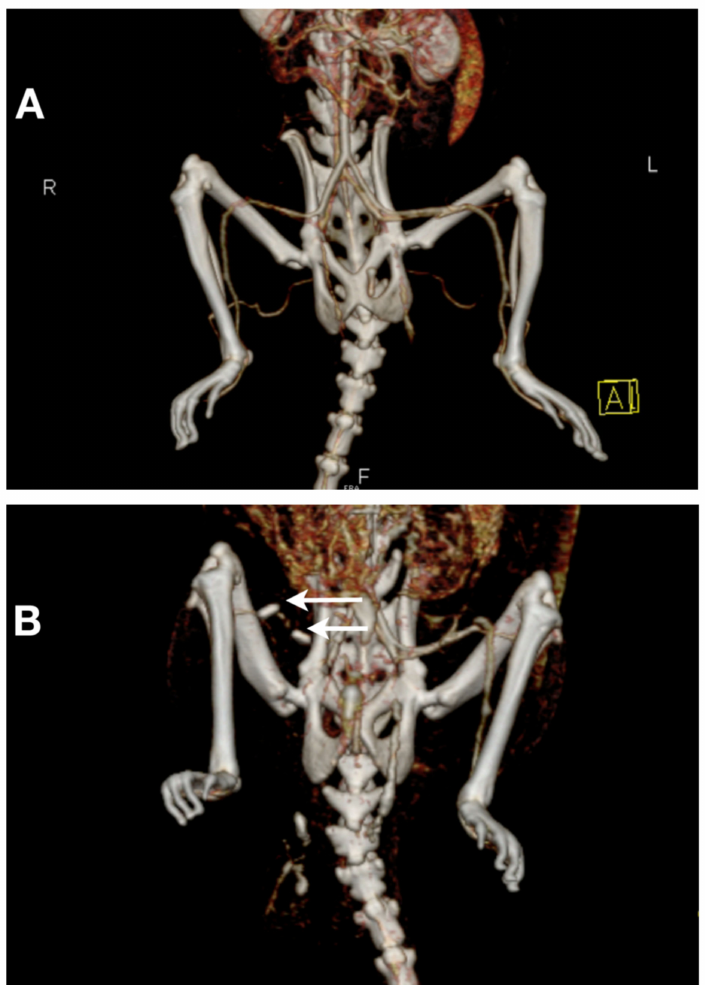
Figure 4. Computed tomography (CT)–angiography demonstrated the absence of collateralization at day 30. ( A ) Volume rendering technique (VRT) images of the hindlimb of a rat from the control group with normal vascularization. ( B ) Image of an animal from group A showing the titanium clips (indicated by arrows) on right common femoral and popliteal artery and also the absence of distal perfusion and